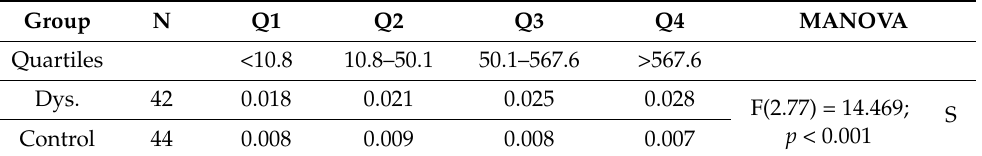
Table 4. Average number of errors (w.r.t. text length) according to 4 levels (quartiles Q1, Q2, Q3 and Q4) of